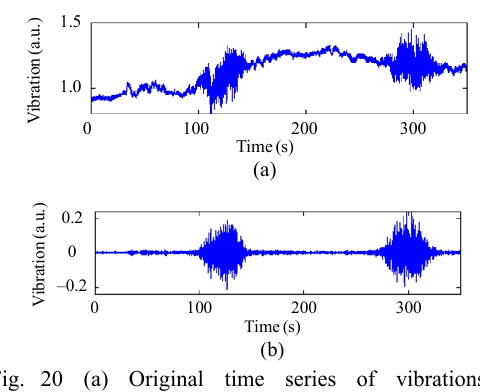
Fig. 20 (a) Original time series of vibrations and (b) vibration signals after wavelet denoising.